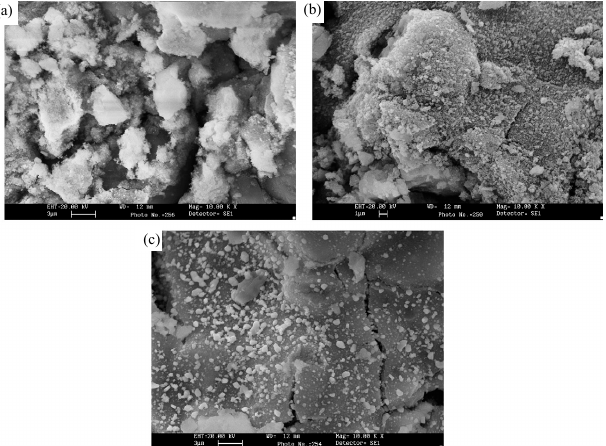
Figure 6. SEM image of the Fe–K/ γ -Al 2 O 3 catalysts after the CO 2 hydrogenation reaction: ( a ) 100 h, ( b ) 300 h, and ( c ) 500 h. Adapted with permission from ref. [57]. Copyright 2009 Elsevier.